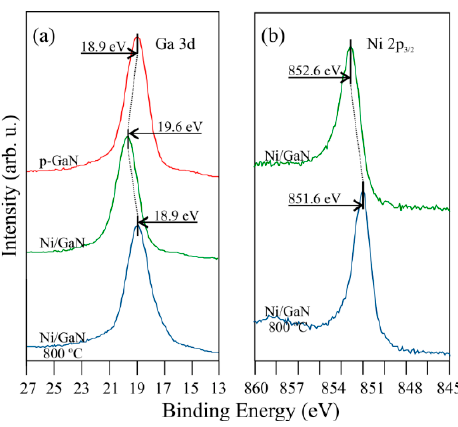
Figure 24. XPS spectra of ( a ) Ga ‐ 3d and ( b ) Ni ‐ 2p 3/2 for bare and Ni ‐ film ‐ covered p ‐ GaN(0001) be ‐ fore and after annealing. Mean film thickness is 1 nm. Data previously published in [30].